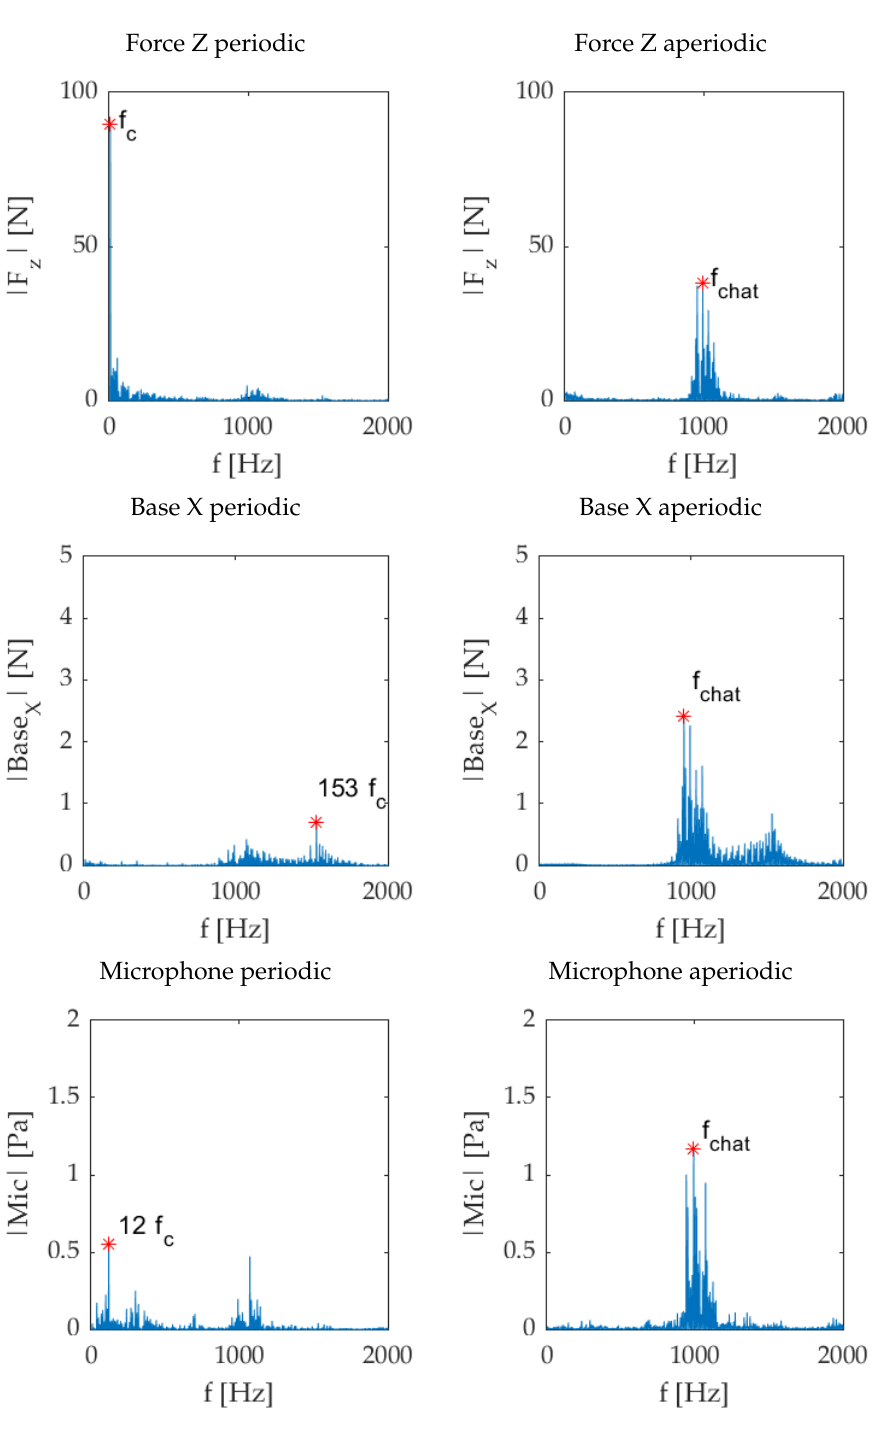
Figure 12. Signal spectra for “Always in chatter”